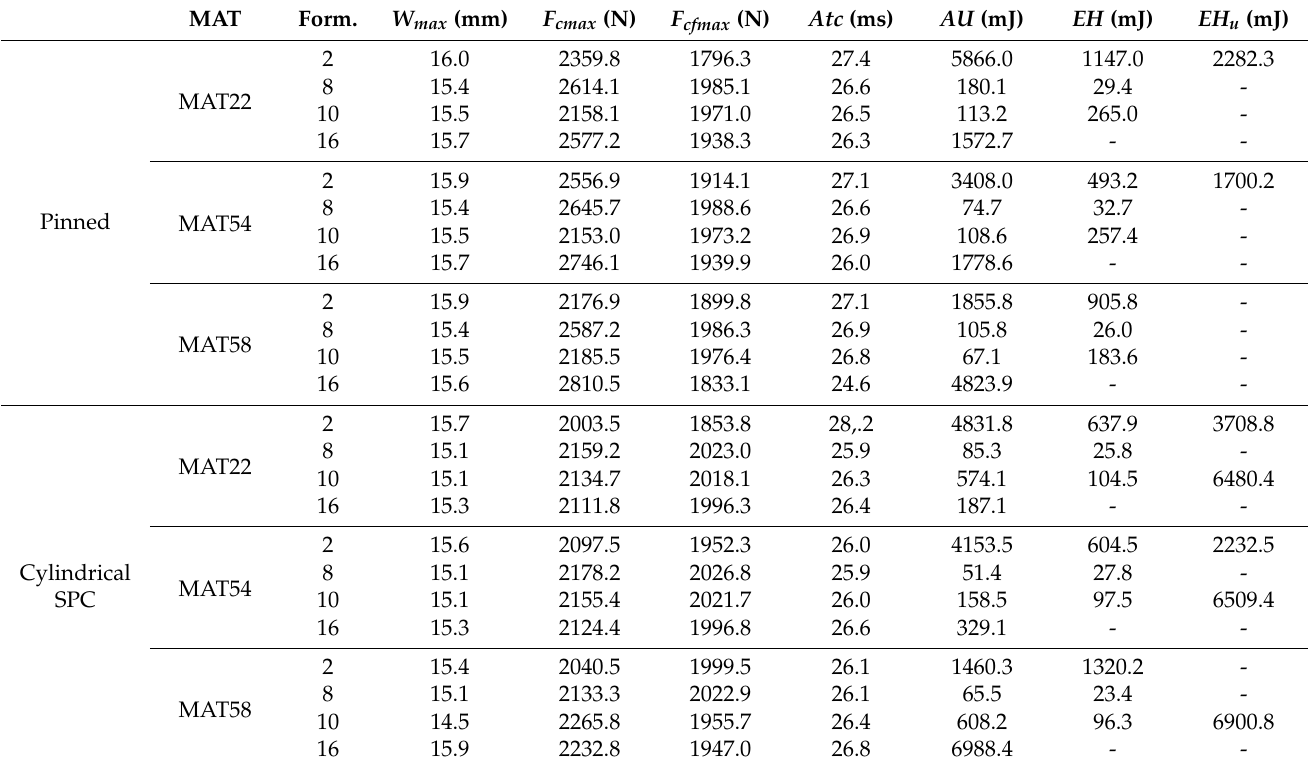
Table 6. Parametric analysis for sample